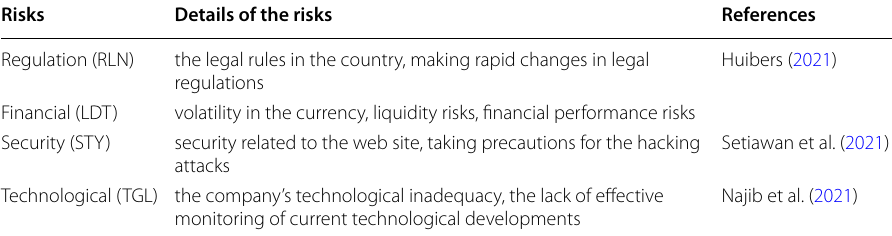
Table 1 Selected investor risks for the fintech